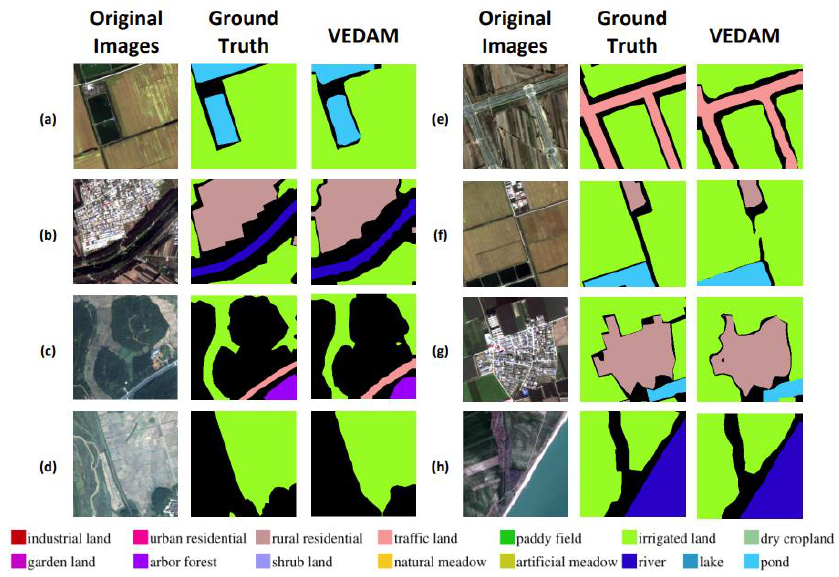
Figure 7. Visualization of segmentation results of VEDAM on the GID Dataset, ( a–h ) represents the visualization results of randomly selected samples. Table 2. Experiment results of the GID dataset by